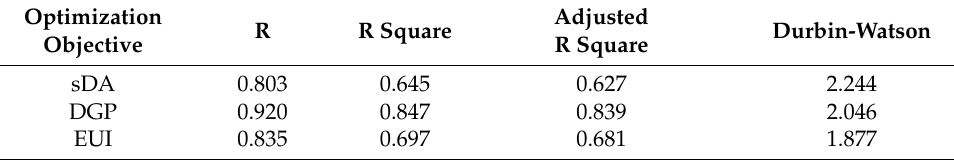
Table 12. Louver shading SAS design parameters linear regression model.